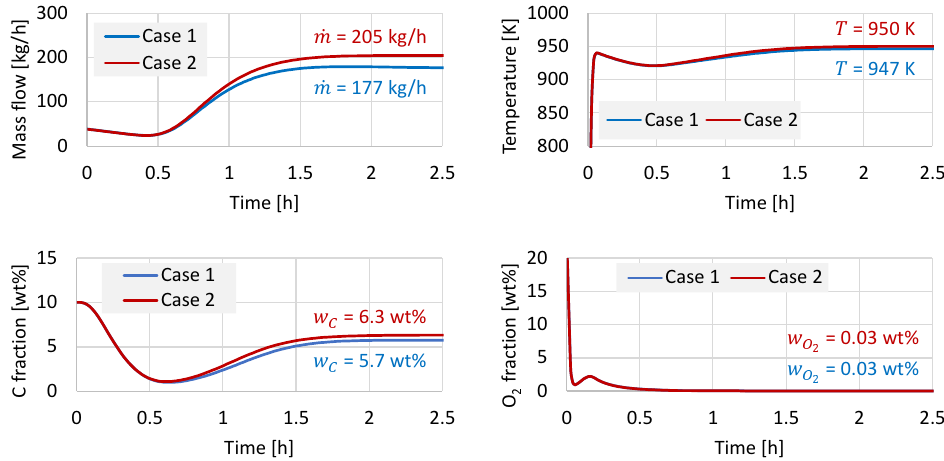
(cid:8) (cid:2) (cid:17) (cid:16)(cid:16) (cid:10)